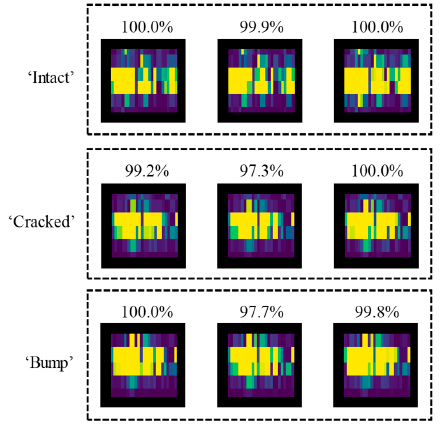
Figure 16. Visualization of the classification results.